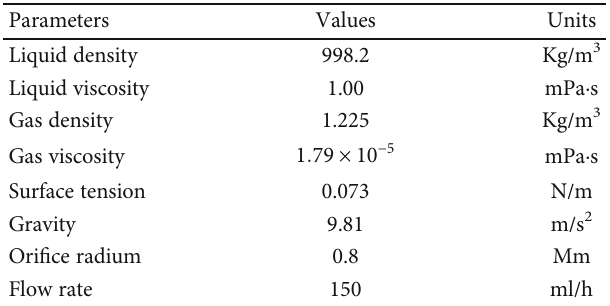
Table 1: Calculation results and experimental veri fi cation conditions.